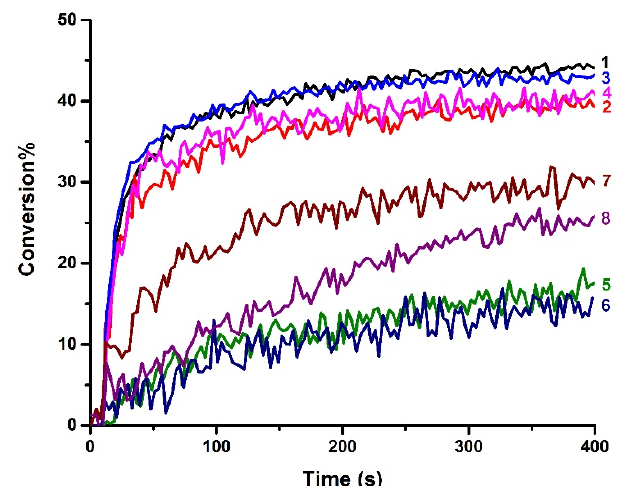
Figure 3. Photopolymerization profiles of EPOX (epoxy function conversion vs. irradiation time) upon LED@365 nm irradiation under air in the presence of (1) BPC1 / Iod (0.5% / 1% w / w ); (2) BPC2 / Iod (0.5% / 1% w / w ); (3) BPC3 / Iod (0.5% / 1% w / w ); (4) BPC4 / Iod (0.5% / 1% w / w ); (5) C5 / Iod (1% / 1% w / w ); (6) C6 / Iod (0.5% / 1% w / w ); (7) C7 / Iod (0.5% / 1% w / w ); (8) C8 / Iod (0.5% / 1% w / w ). The irradiation starts from t = 10 s. Table 2. Final epoxy function conversion for EPOX and acrylate function conversion for TMPTA